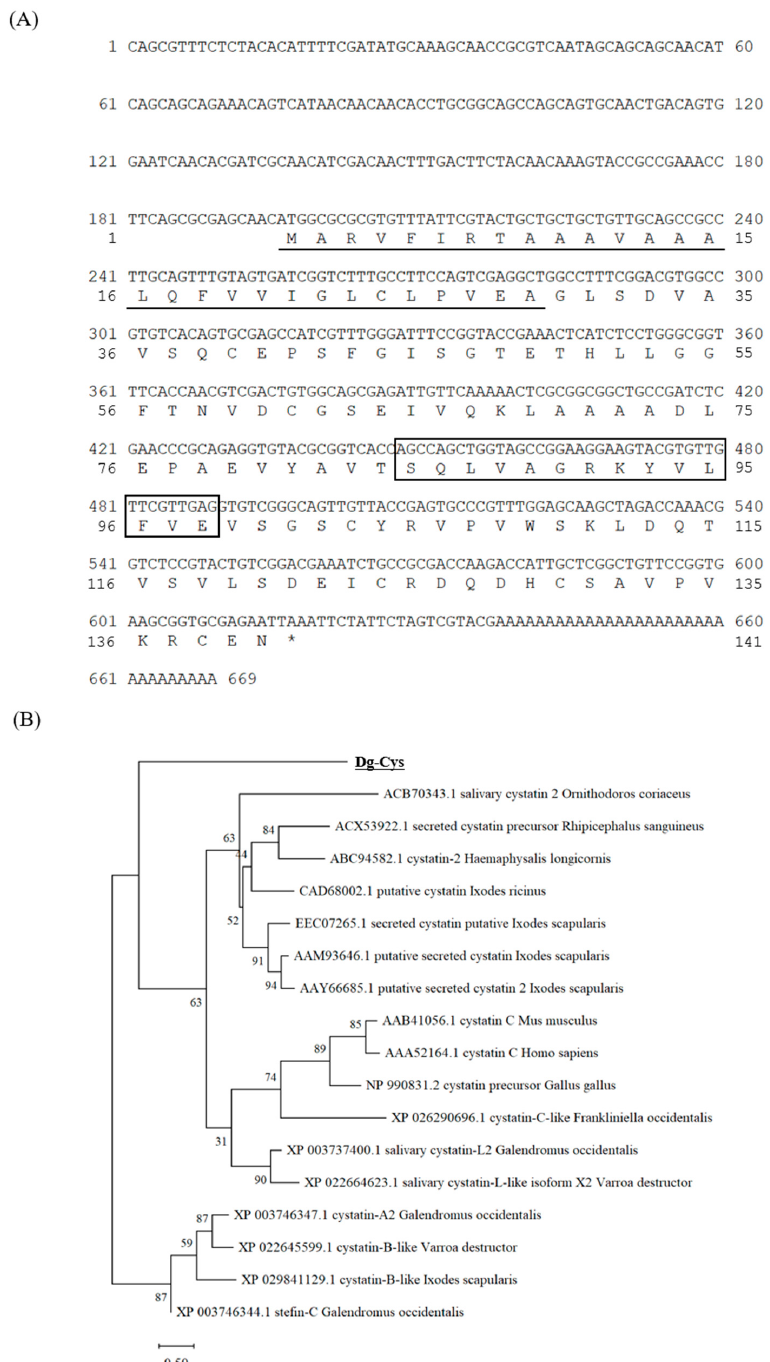
Figure 1. Cloning of a cystatin-like molecule from Dermanyssus gallinae . ( A ) Nucleotide and deduced amino acid sequences of cDNA encoding a D. gallinae cystatin-like molecule ( Dg-Cys ). Putative signal peptide sites were underlined, and the cystatin-conserved site was boxed. ( B ) A phylogenic tree based on the deduced amino acid sequence of Dg-Cys . The tree was built with the maximum likelihood method using the MEGA Ⅹ software [20]. Numbers indicate bootstrap percentage (1000 replicates). The scale indicates the divergence time. *Stop